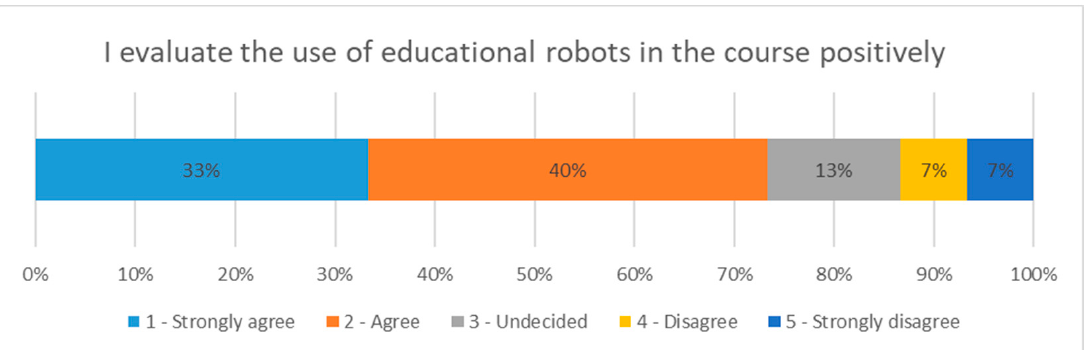
Figure 7. Expression of students’ attitudes to the statement: “I evaluate the use of educational robots in the course